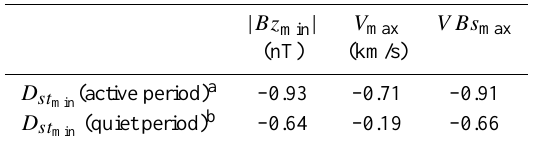
Table 1. Summarized correlation coefficient for D st V max and V Bs max .